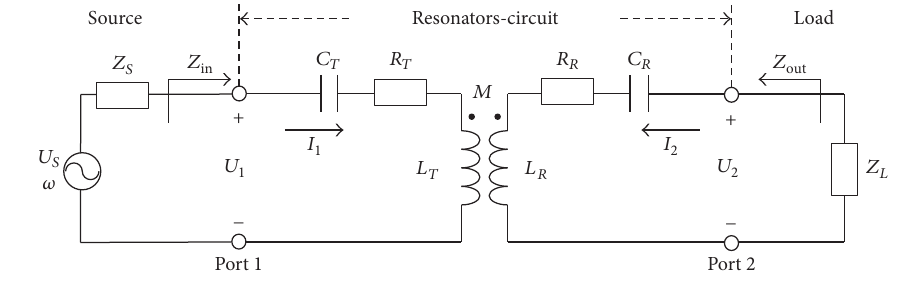
Figure 1: Circuit model of a series-compensated WPT system.